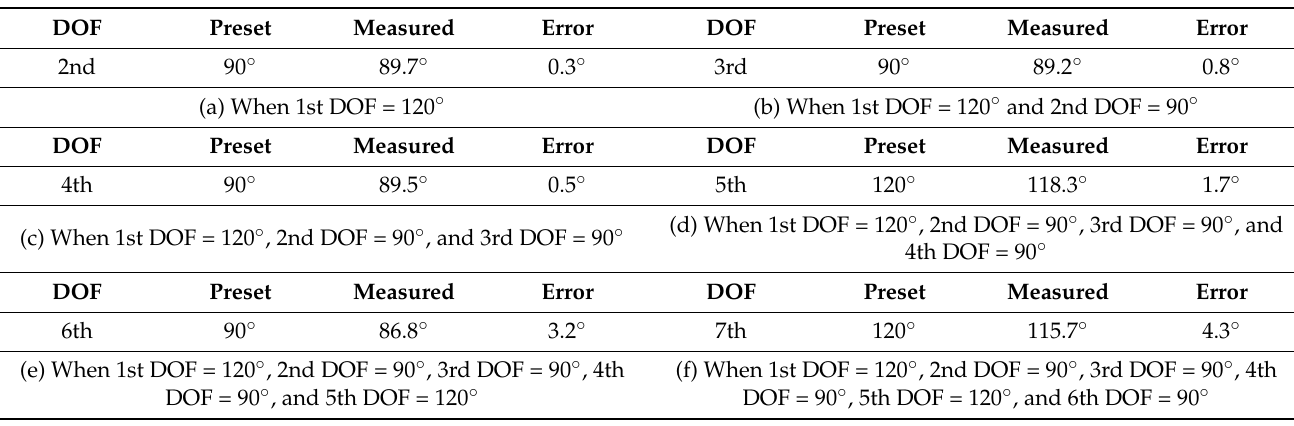
Table 3. Motion measurement based on coupling analysis.